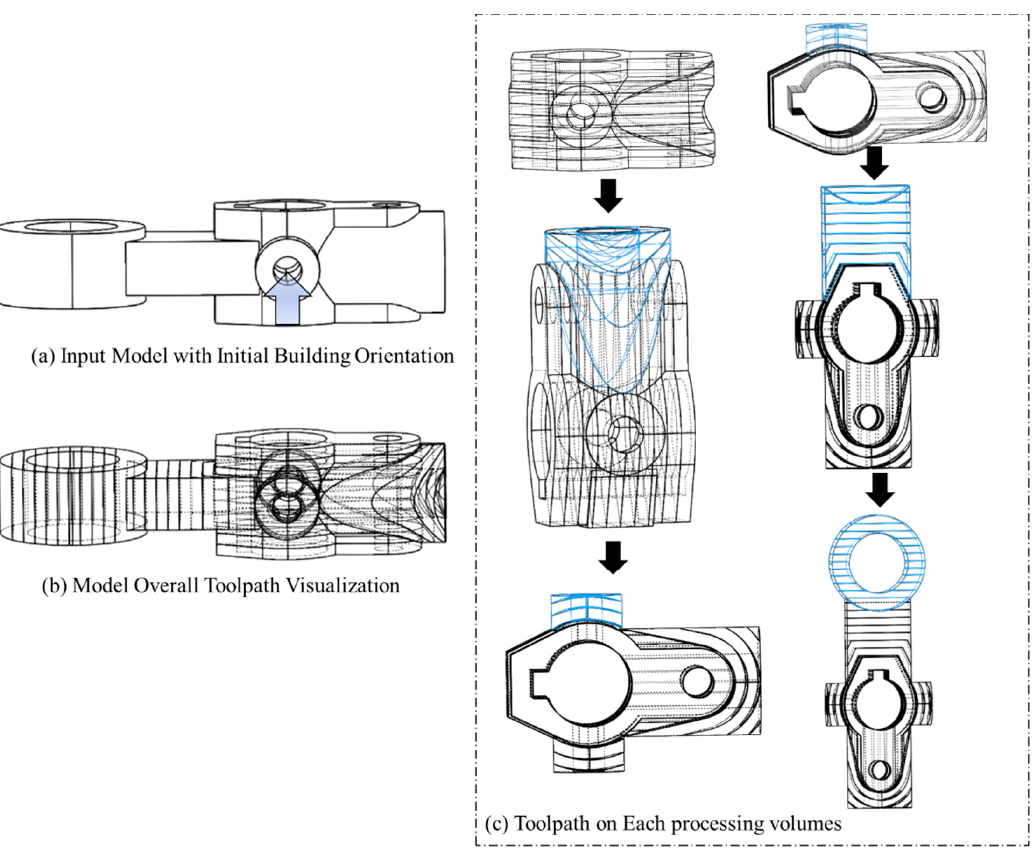
Figure 11. Trajectory accumulation on model with first defined initial building orientation for model (a).